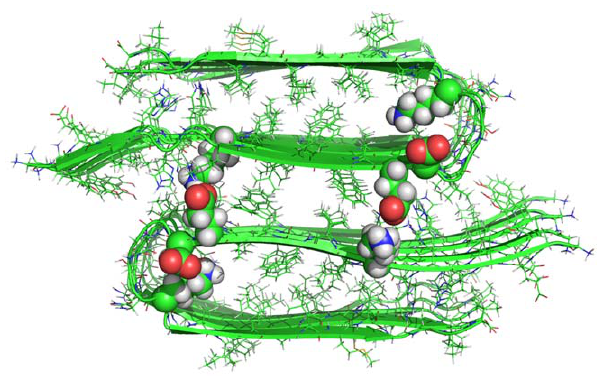
Figure 5. The structure of the starting configuration of of the interactions of Asp 23 /Lys 28 and Lys 16 /Glu 22 for the double layer 16–21P model. The positions of the residues originally involved in the formation of the salt bridge are represented in sphere visualization to emphasize their location. doi:10.1371/journal.pone.0041479.g005 intervals for further analysis. The temperature of 330 K is selected as a compromise between experimental stability of the amyloid fibrils [48] and thermally enhanced sampling [49], [50]. Two